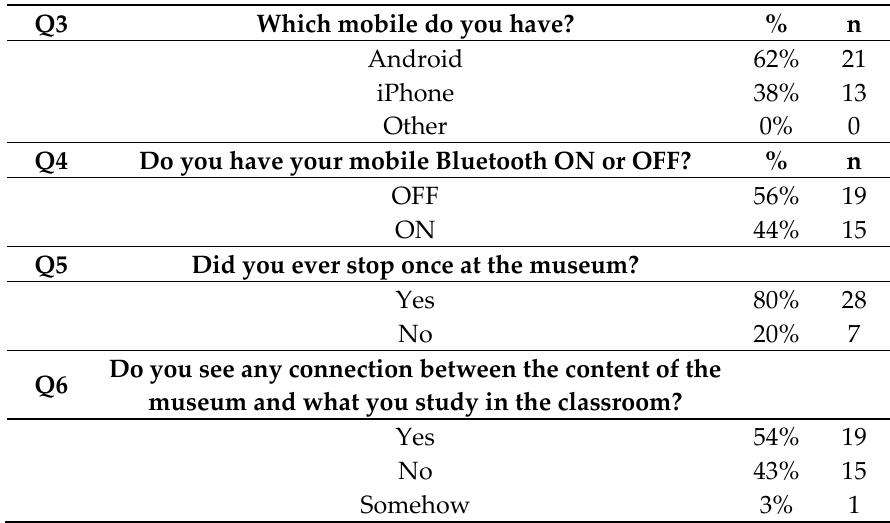
Table 2. Questions of the interview.